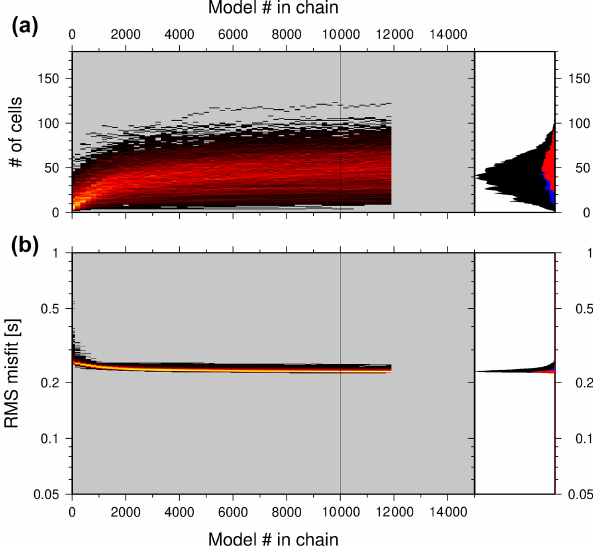
Figure 6. Evolution of misfit along Markov chains. The histogram distribution of the data misfit (b) and model dimension (number of cells, a ) during the evolution along 1000 Markov chains are shown using a heat map colour scale. The black line at 10000 shows the end of the burn-in phase; the following models are used to derive the final model. Relative histogram plots of the distribution of data misfit (b) and model dimension (a) are added on the right-hand side, with all models shown in black; the blue models are the post-burn- in ones; the red are the 90% best-fitting models. The best fitting models are typically characterized by higher model dimensionality. The forward problem (travel time calculations) was solved for more than 3 . 5 × 10 8 models. Note the log scale for the iteration number and data misfit.